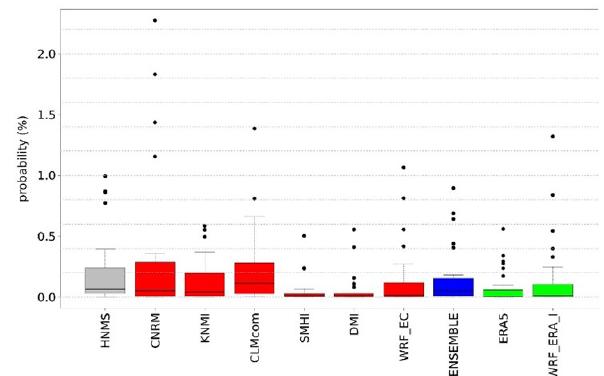
Figure 3. Box plot presenting RR20FD copula method probabili- ties for observations and models.